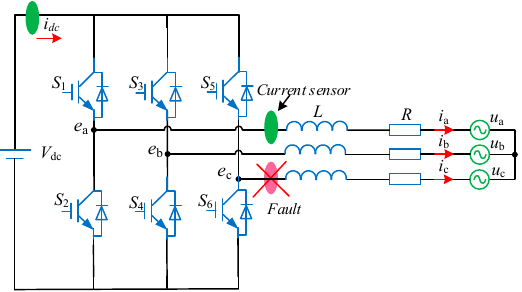
Figure 4. Current-sensor fault of a three-phase grid-connected converter.